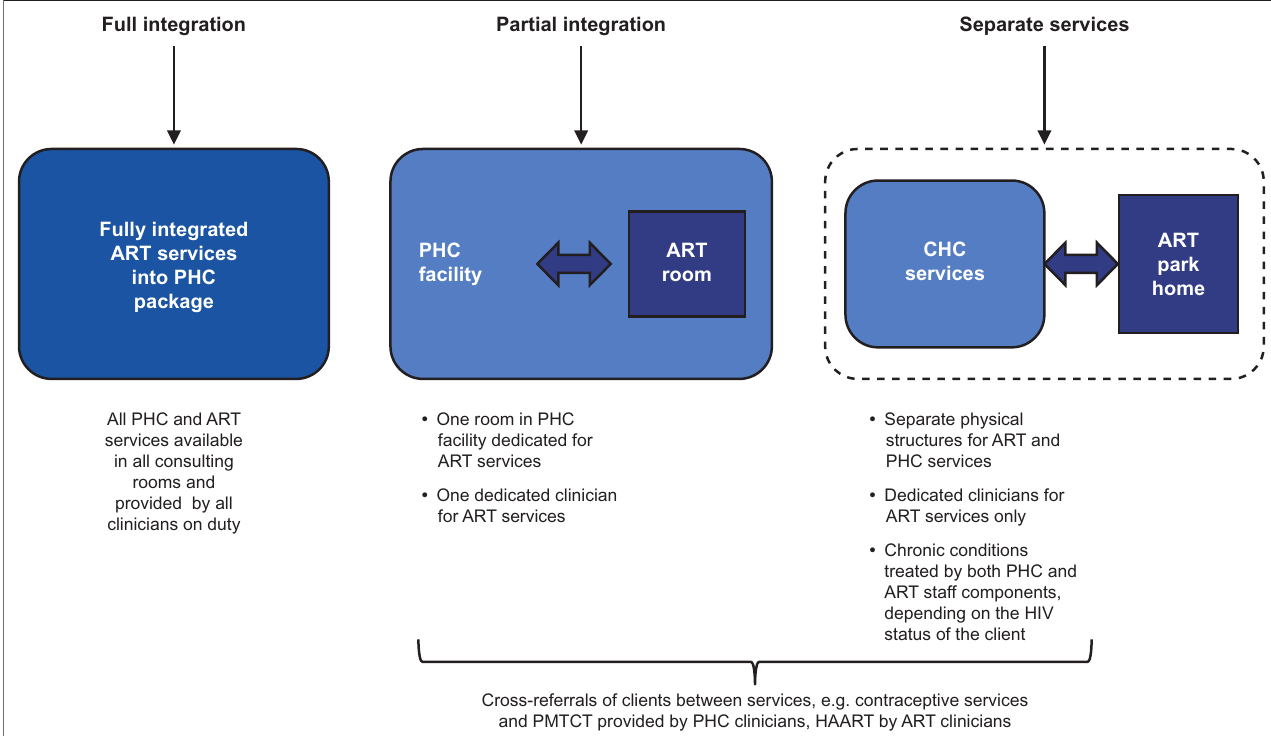
All PHC and ART services available in all consulting rooms